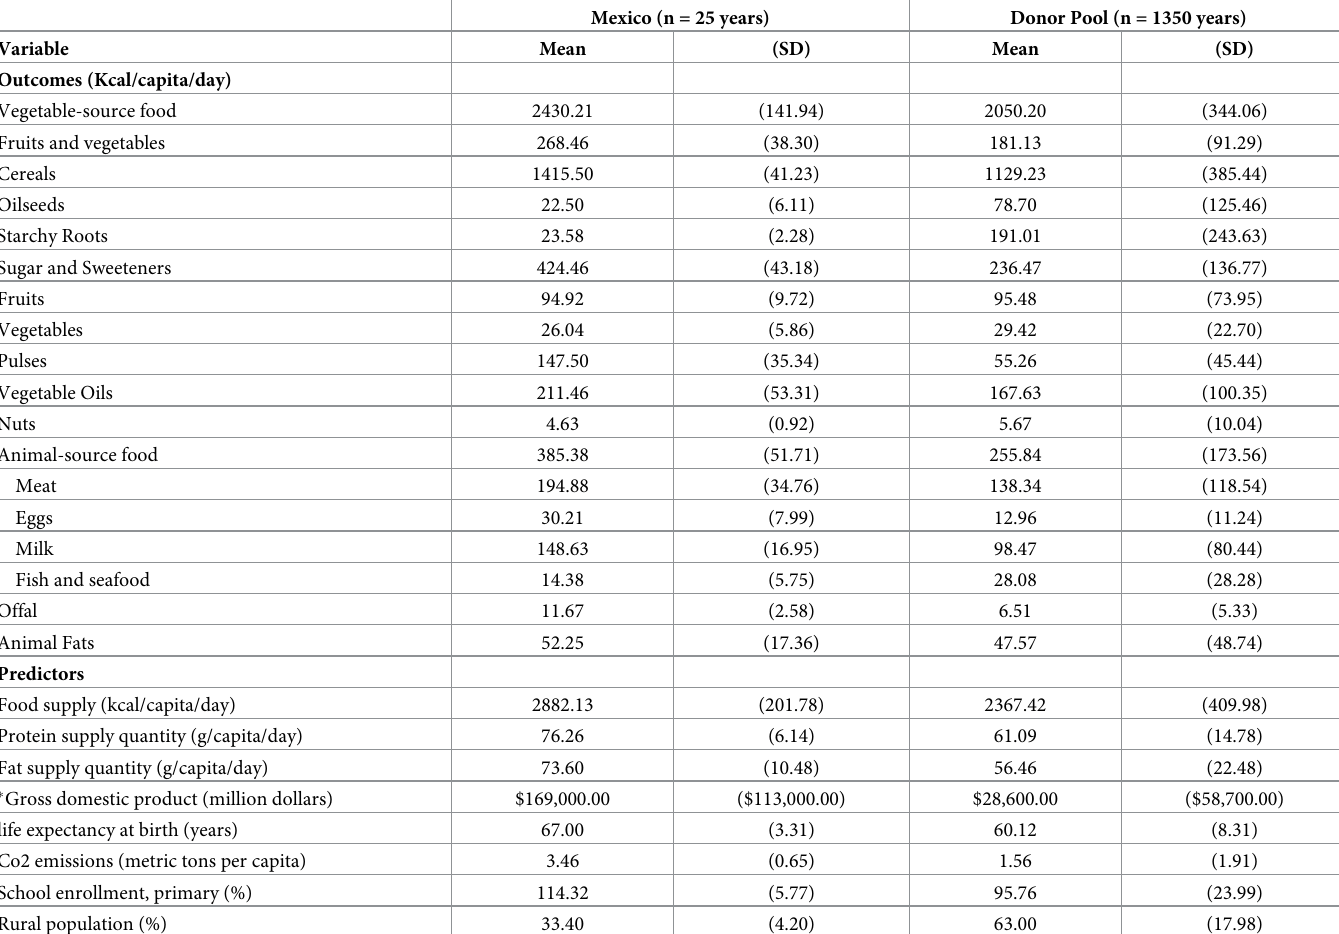
Table 1. Apparent consumption of food energy, nutrients, demographic, and economic characteristics for Mexico and donor pool countries in the pre-intervention period, from 1970 to